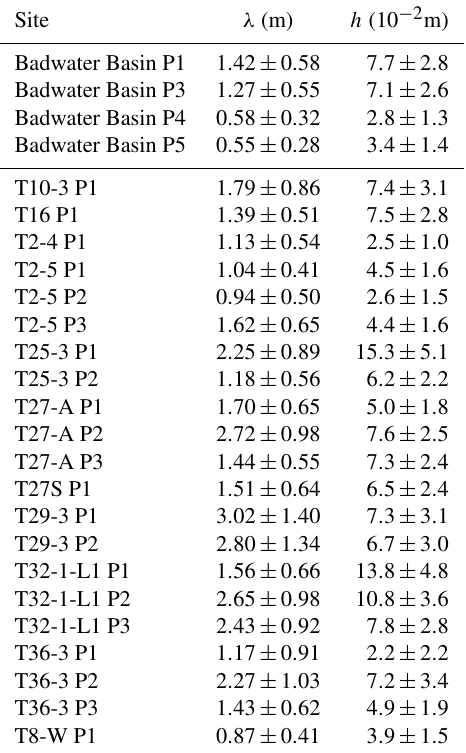
Table 14. Average pattern wavelengths ( λ ) and ridge heights ( h ) calculated from surface scans of salt pans showing polygonal shapes. Ranges indicate the standard deviation of each set of mea-